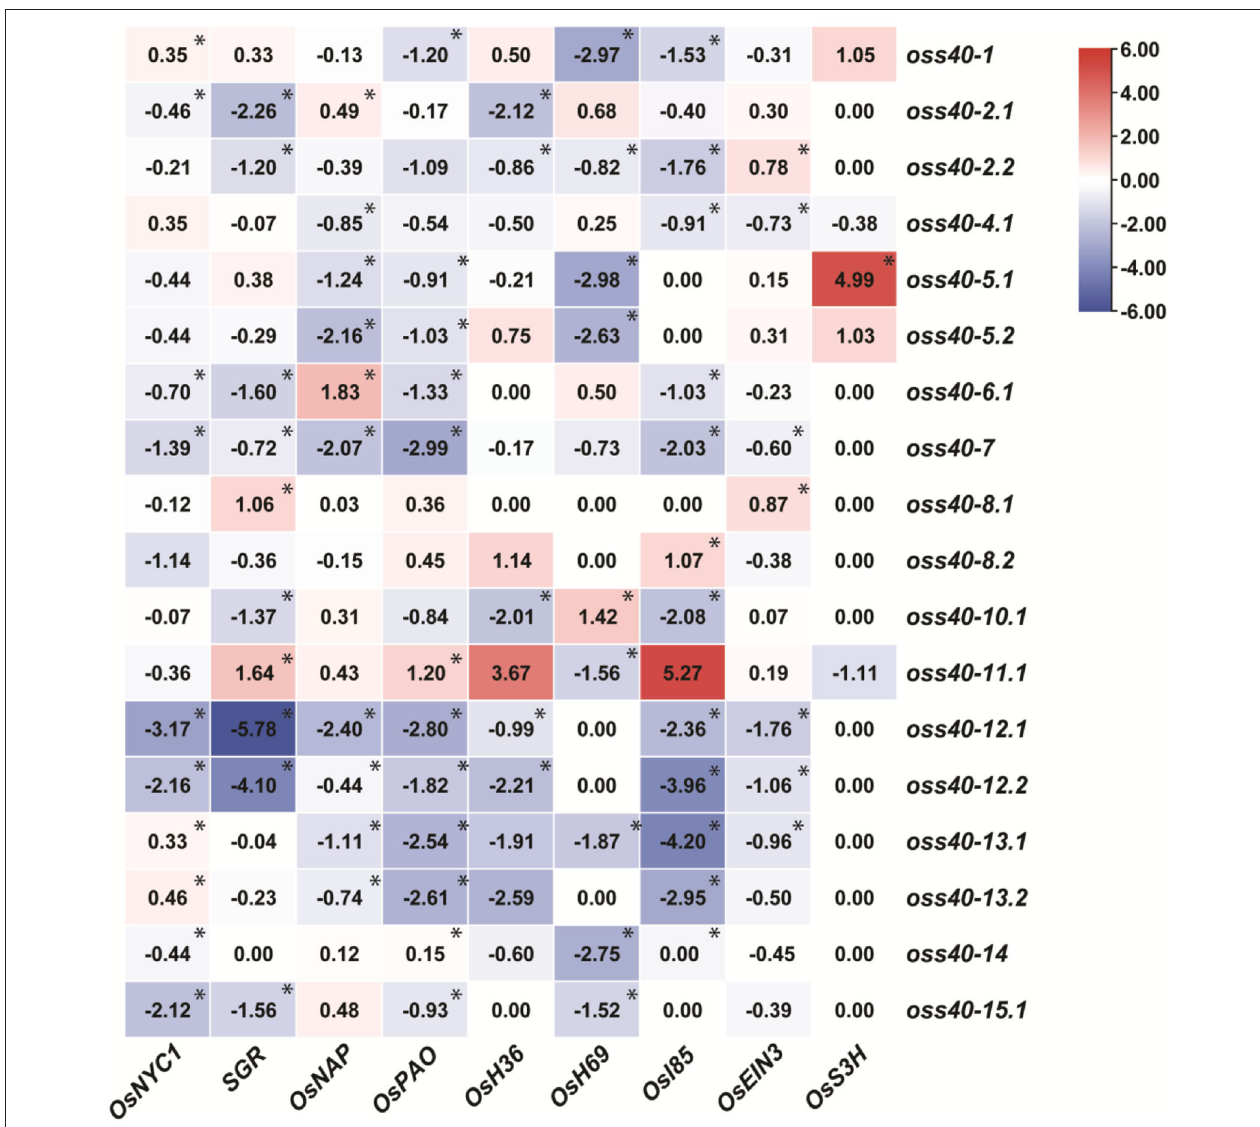
FIGURE 6 | Altered expression of CDGs and SAGs in different oss40 mutant lines. Heatmap representation shows the CDGs ( OsNYC1, SGR, and OsPAO ) and SAGs ( OsH36, OsH69, Os185, OsNAP, OsEIN3 , and OsS3H ) expression level in different mutant lines. The expression levels of genes are presented using fold-change values log2 format. The data indicate the relative expression levels normalized to that of the internal control OsACTIN . Red and blue colors correspond to up- and down-regulation of the gene expressions, respectively. Mean and SD values were obtained from three biological replicates. Significant differences of the expression levels normalized to WT were evaluated using Student’s t -test (* p < 0.05).